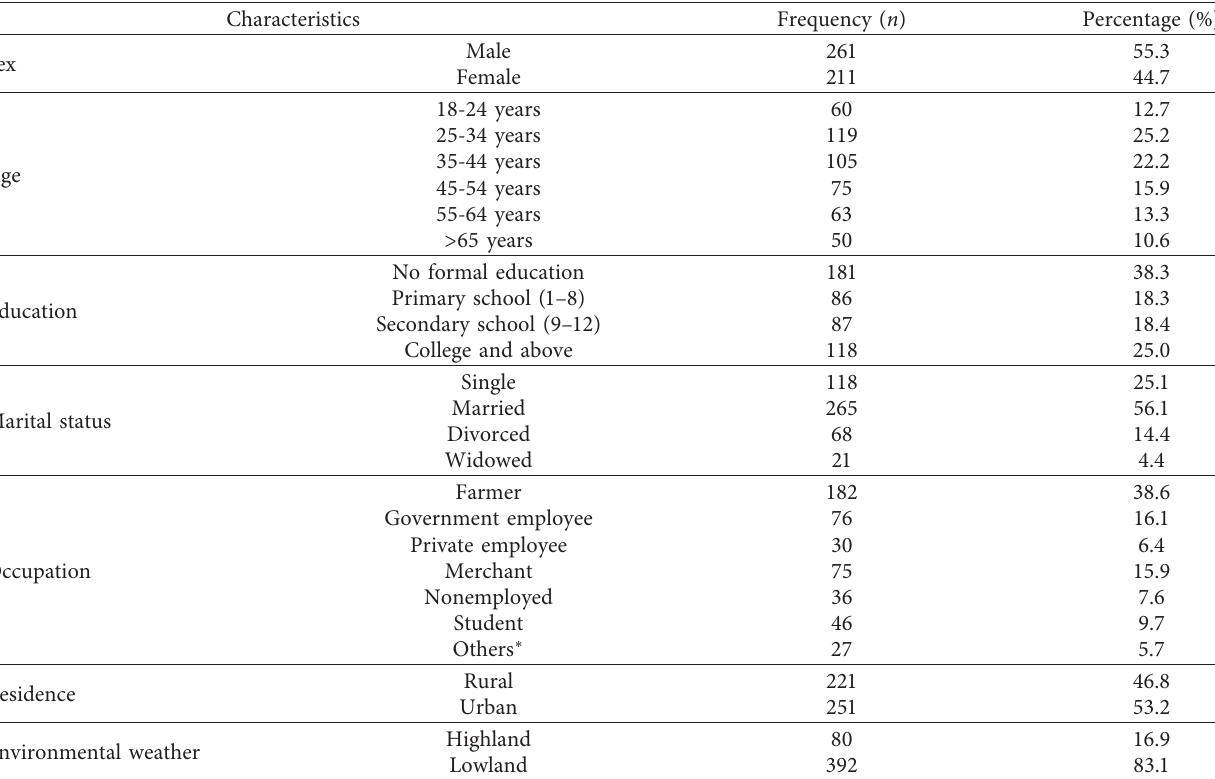
Table 1: Sociodemographic characteristics of adult patients attending the OPD in Tigray region hospitals, Ethiopia, 2019 ( N � 472). Characteristics